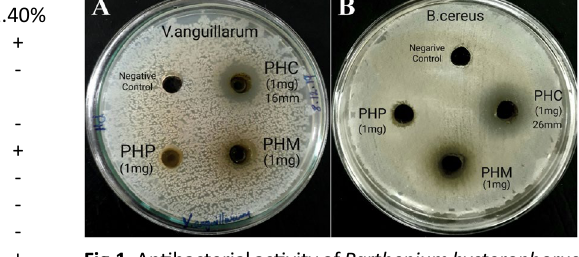
Fig.1. Antibacterial activity of Parthenium hysterophorus extracts; A: against Vibrio anguillarum ; B: against Bacillus